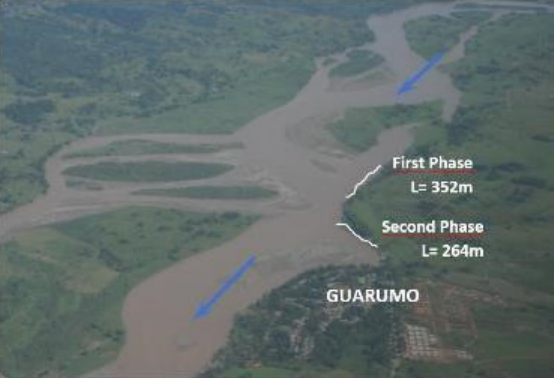
Figure 17. Cauca River, Guarumo: location of the two vane fields (Hidroconsulta, 2008).